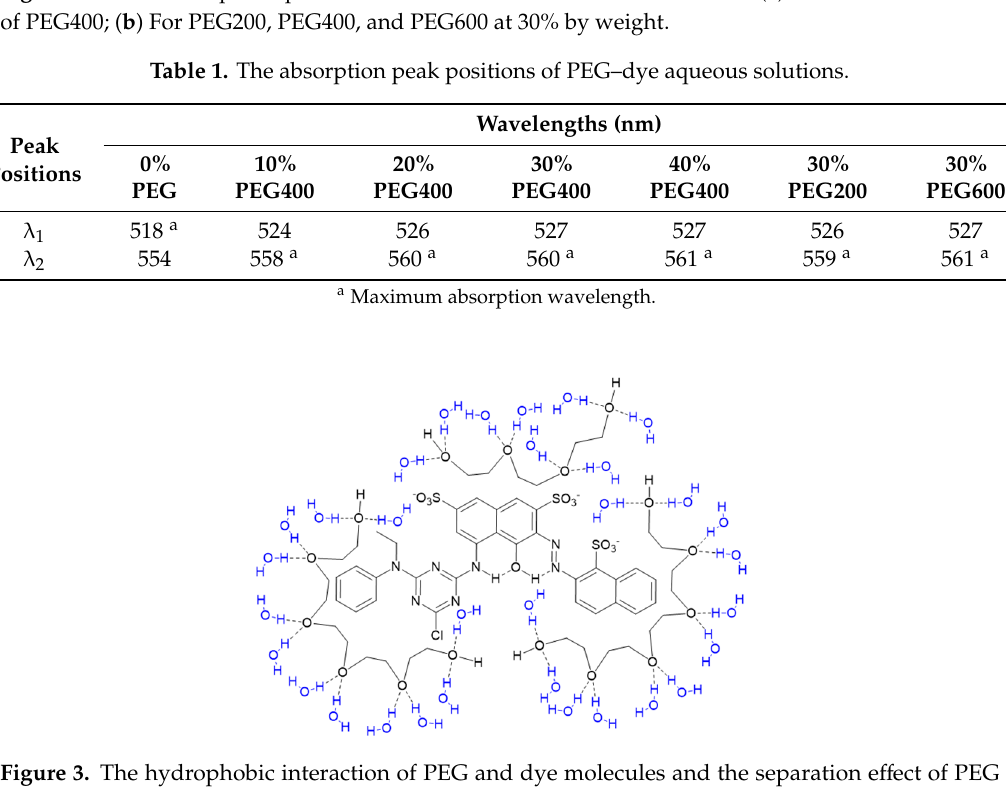
Figure 3. The hydrophobic interaction of PEG and dye molecules and the separation effect of PEG macromolecules. Table 1 lists all the peak positions for different dye solutions. It is clear that the maximum absorption peak of the dye solution, λ 1 , changed to λ 2 when PEGs were added to the solution due to the rapid increase of the peak height of λ 2 . Table 1. The absorption peak positions of PEG–dye aqueous solutions.